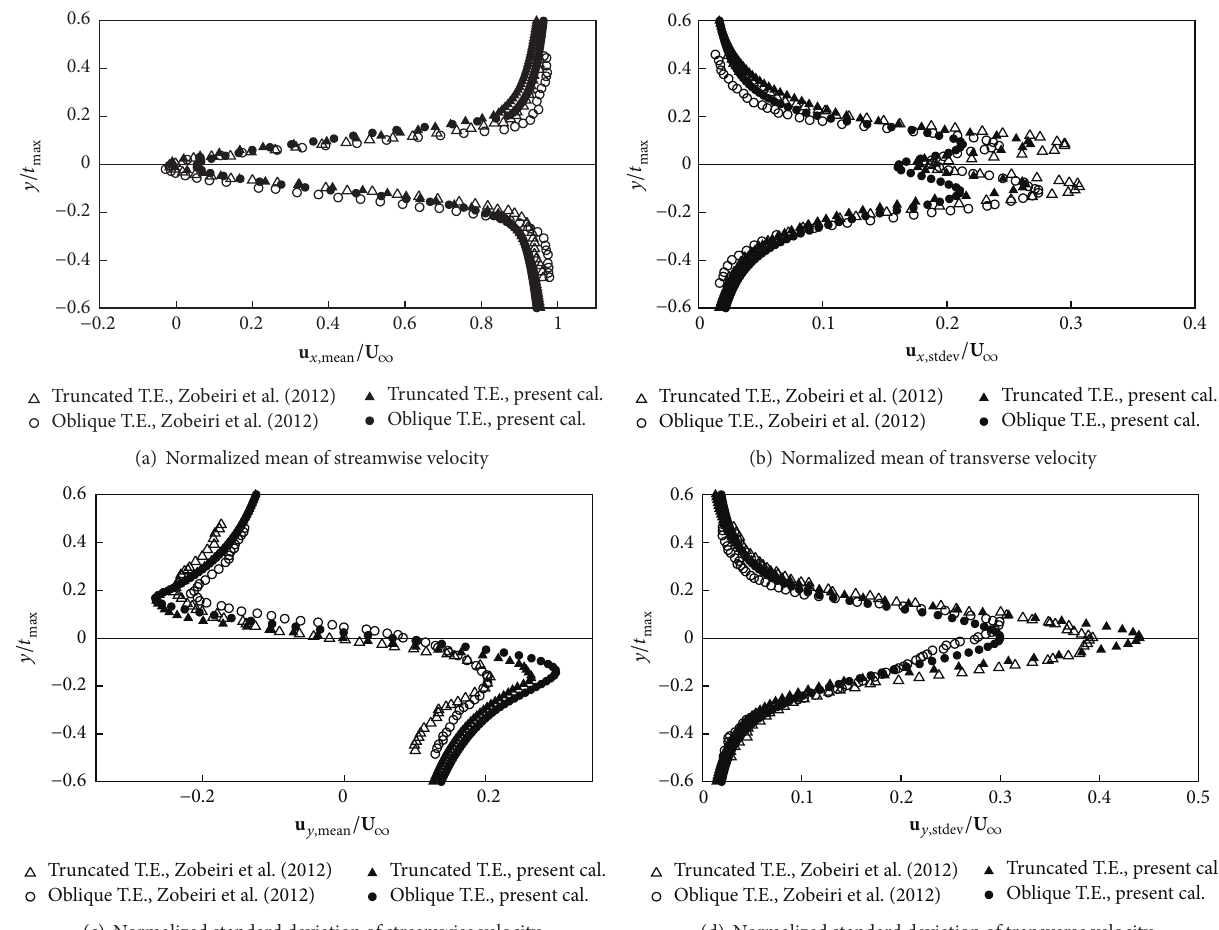
Figure 8: Mean and standard deviation of velocities at 𝑥/𝑐 = 0.516 for Re = 10 6 . The experimental data by Zobeiri et al. [11] were measured at 𝑥/𝑐 = 0.52 and 0.528 for truncated ( 𝛽 = 0 ∘ ) and oblique ( 𝛽 = 60 ∘ ) trailing edges, respectively, and the reported Reynolds number of the flow is about 2 × 10 6